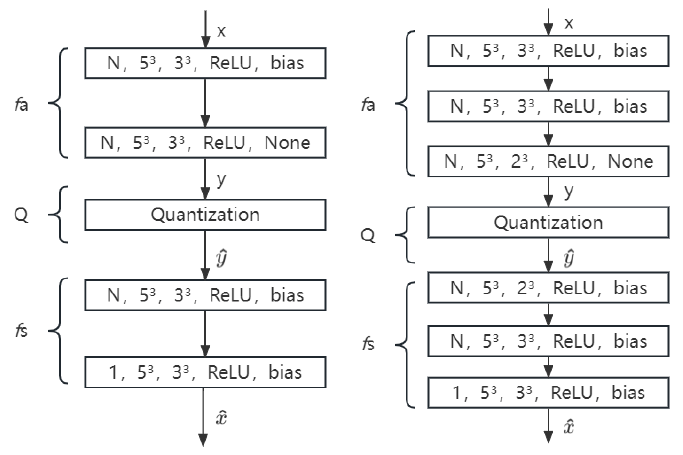
Figure 2. The architecture of the used neural network with different layers of 2 strides. Layers are specified using the following format: the number of feature maps, filter size, strides, activation, and bias. Relu in the figure is the reference activation function. Left to right shows 2 layers, 3 layers, and 4 layers with 2 strides, respectively.